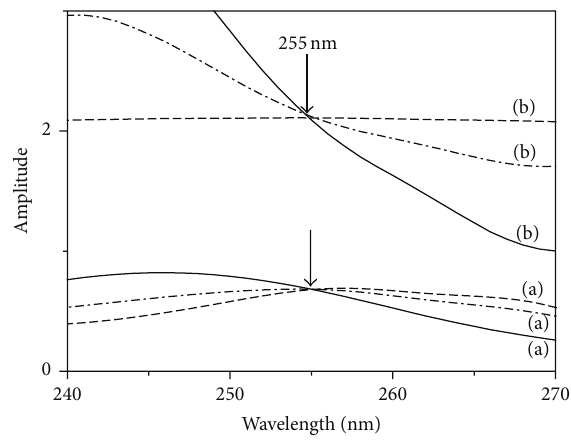
Figure 5: The spectra of 16 𝜇 g/mL RU (--- -), 16 𝜇 g/mL AA (—), and a mixture containing 8 𝜇 g/mL RU and 8 𝜇 g/mL AA (- ⋅ - ⋅ -). (a) Absorption spectra in methanol. (b) Ratio spectra using a divisor of 8 𝜇 g/mL RU in methanol as a